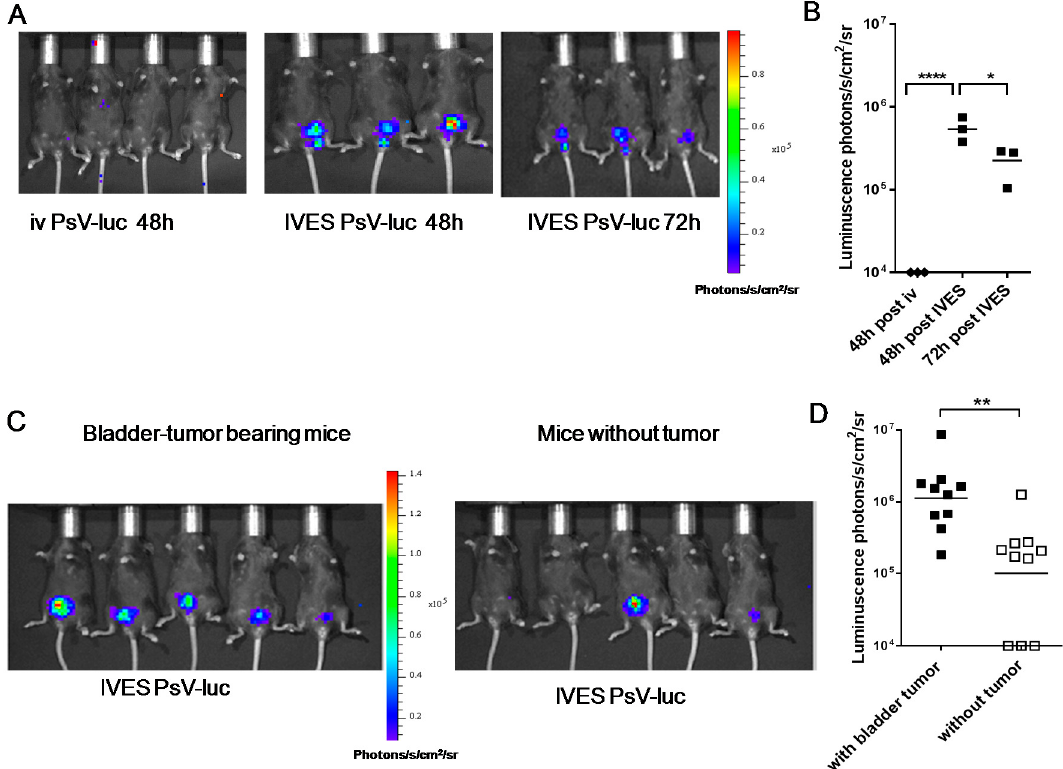
Figure 3. Bladder-tumor infection with PsV-luc: Efficacy of PsV-luc pseudoinfection was assessed by bioluminescence imaging 48 and/or 72 h after intravenous (iv) or intravesical (IVES) administration in mice bearing MB49 bladder-tumors ( A , B ) or 48 h after IVES administration in mice with or without bladder tumors ( C , D ). Representative Xenogen photographic images are shown in ( A , C ), while luminescence quantification of bladder/bladder tumors are shown in ( B , D ). Significant differences following a Student t -test are indicated by * for p < 0.05, ** for p < 0.01, and **** for p < 0.0001.